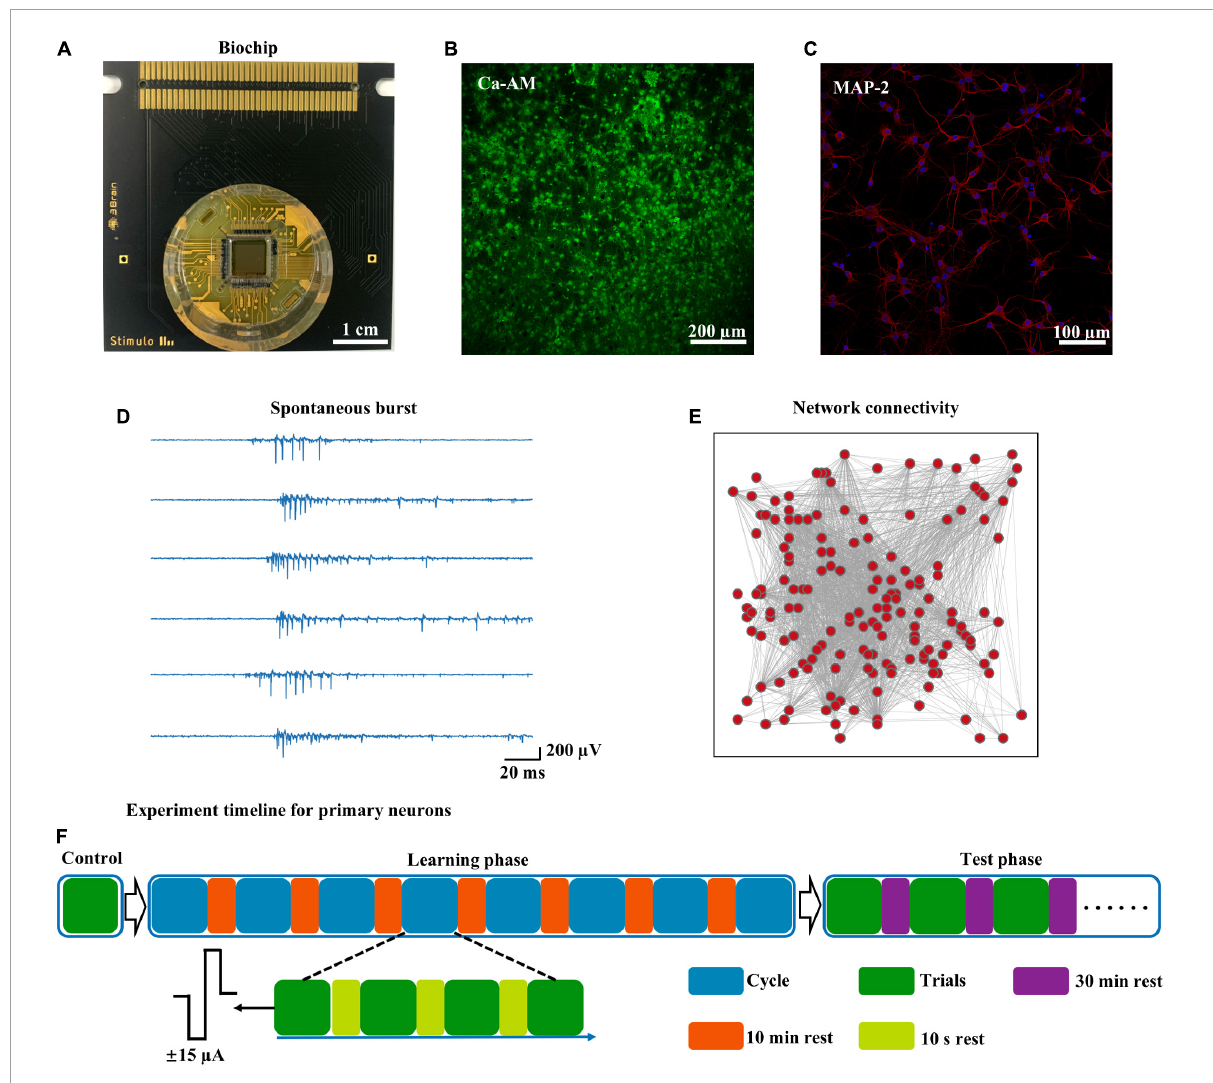
FIGURE1 High-density recording of spontaneous activity and experimental workflow. (A) Overview of the HD-MEA biochip, including 4,096 recording electrodes and 16 stimulus electrodes. (B) The neurons on the biochip were stained with Ca-AM and photographed under confocal microscopy [at 7 days in vitro (DIV)]. (C) The same batch of neurons cultured in a culture dish was stained with MAP-2 (DIV 14): neurons (red), nucleus (blue). (D) Raster of spontaneous spikes in cultured neuronal networks (time: 60 s). (E) Representative functional network diagram of spontaneous activity (time: 60 s). (F) Experimental workflow for the learning phase and test